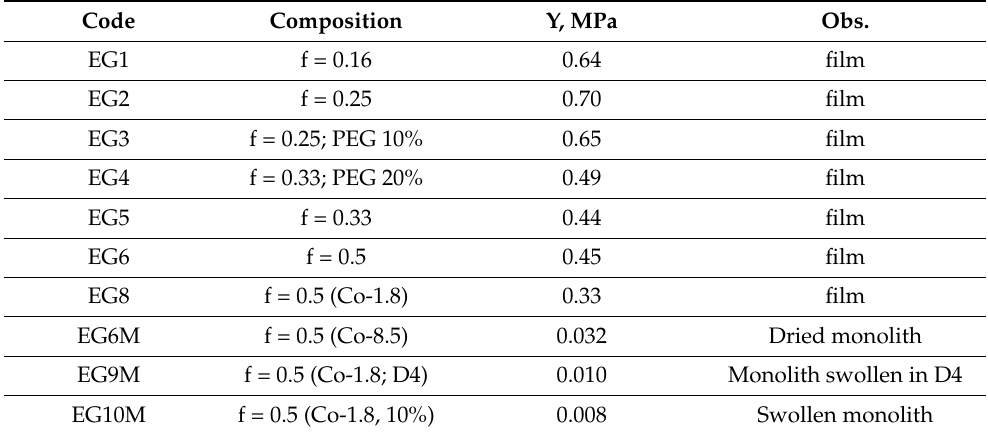
Table 4. Young’s modulus of the porous silicone films measured on stress–strain and for monoliths in compression